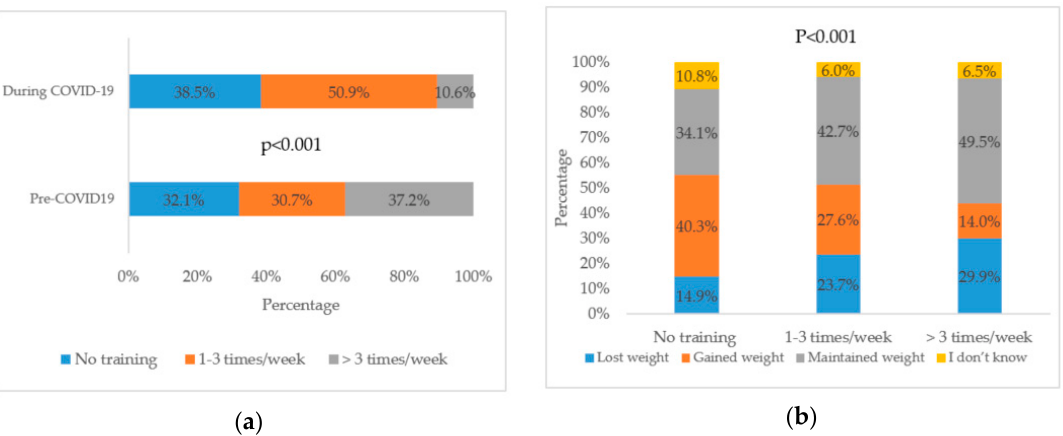
Figure 1. Physical activity pre- and during COVID-19 pandemic ( a ) Frequency; ( b ) Change in weight. The p values indicate the statistical significance of McNemar test. The p values indicate the statistical significance of chi-square test.